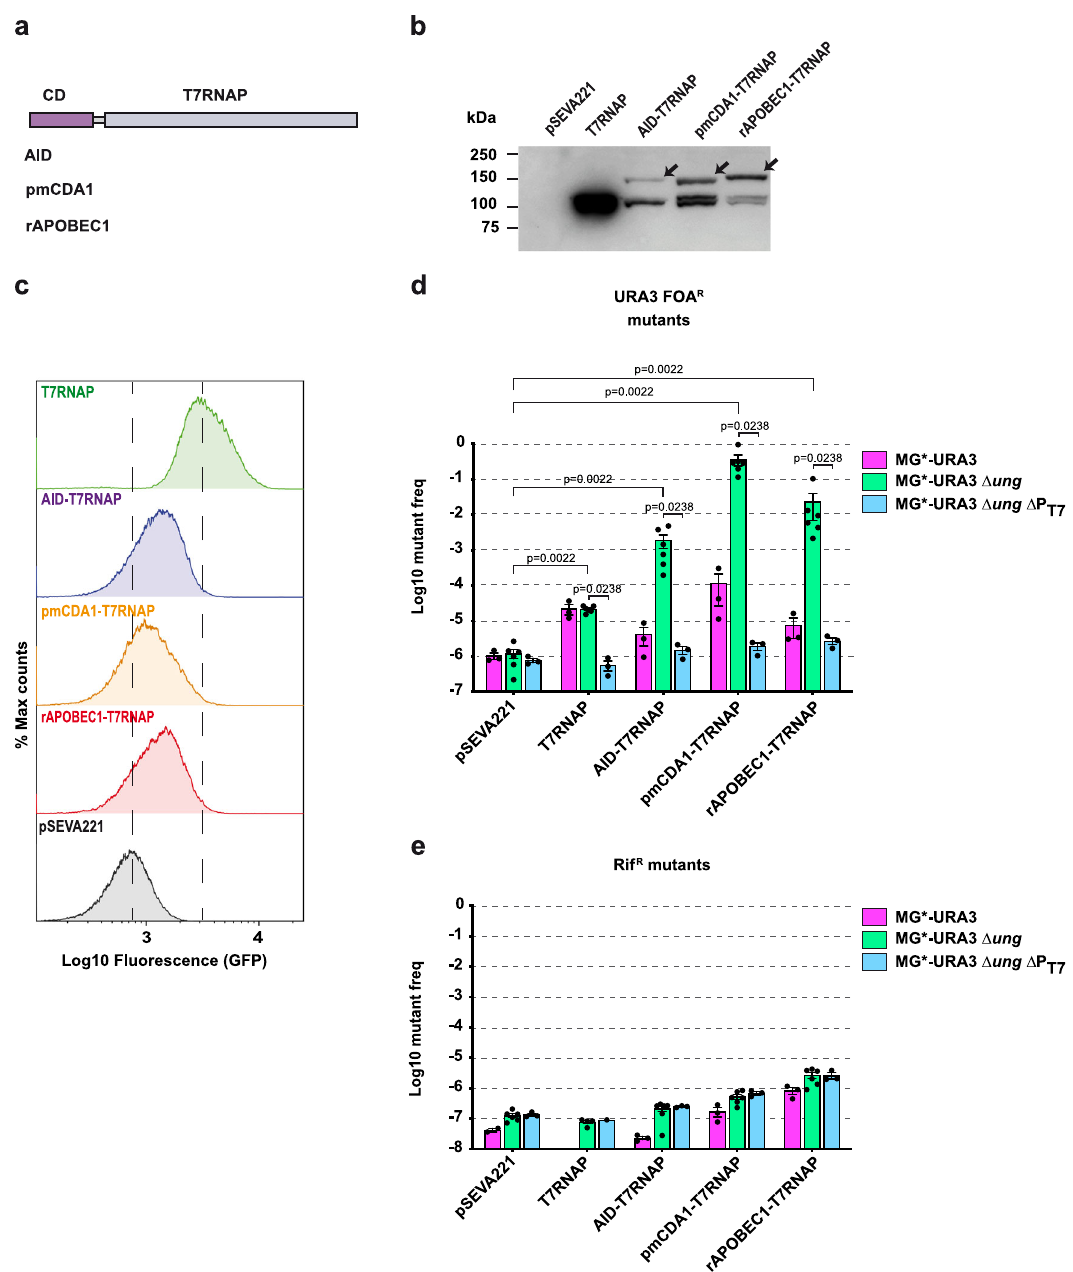
Fig. 2 Expression and mutagenic activity of AID-T7RNAP, pmCDA1-T7RNAP, and rAPOBEC1-T7RNAP. a Scheme of the different CDs fused to the T7RNAP by the linker (G 3 S) 7 . b Expression of the different fusions determined by western blot analysis of the cell extracts from induced cultures of the strain MG*-URA3 Δ ung . A representative immunoblot is shown from two independent experiments with similar results. c Processivity of the fusions assessed by fl ow cytometry analysis to detect expression of GFP in the induced cultures. The gating strategy and the corresponding pseudocolor plots are shown in Supplementary Fig. 3b. d , e Mutagenic activity in URA3 ( d ) and rpoB ( e ) of the different fusions using as hosts MG*-URA3, MG*-URA3 Δ ung , and MG*-URA3 Δ ung Δ P T7 . The histograms d and e show the single values (black dots), the means (bars), and standard errors (lines) of at least three independent experiments ( n = 3, except for the strain MG*-URA3 Δ ung n = 6). The statistical analysis was done using two-tailed Mann – Whitney test. Exact p values ( p ) are indicated in the fi gure. A p value < 0.05 was considered signi fi cant. Source data are provided as a Source data fi